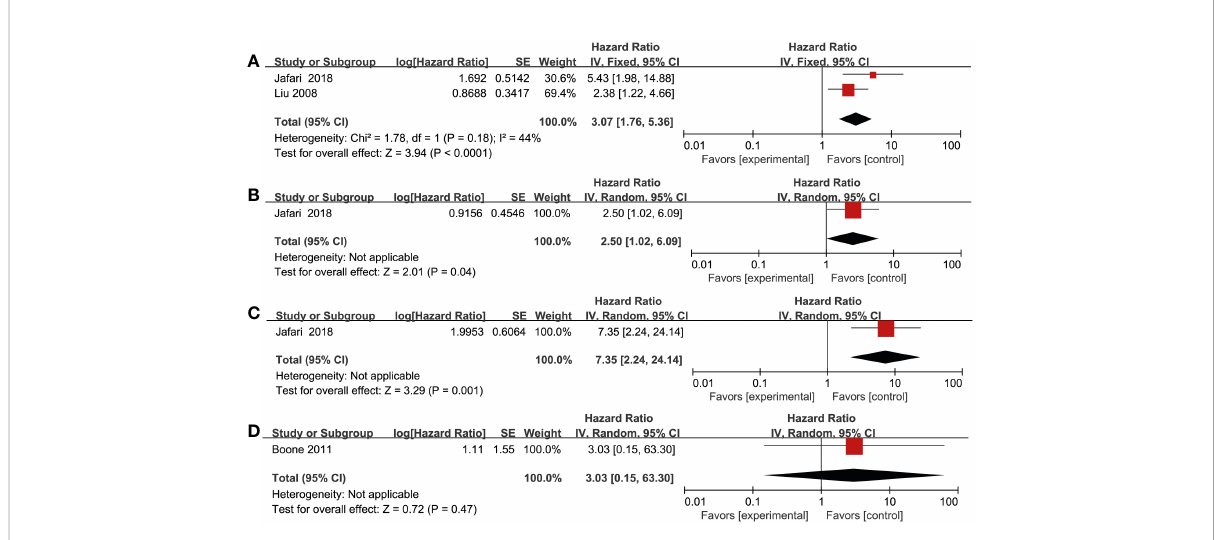
FIGURE 3 Forest plot illustrating the association between various RTKs and DFS in melanoma. (A) VEGF-R3, (B) VEGF-R1, (C) VEGF-R2, (D)